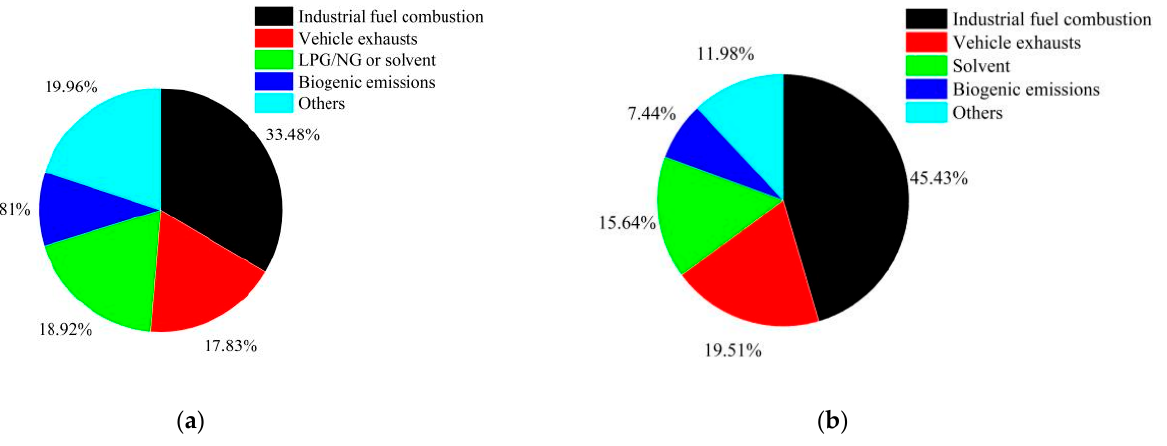
Figure 6. Source apportionment of VOCs at Shenyang ( a ) and Tianjin ( b ).